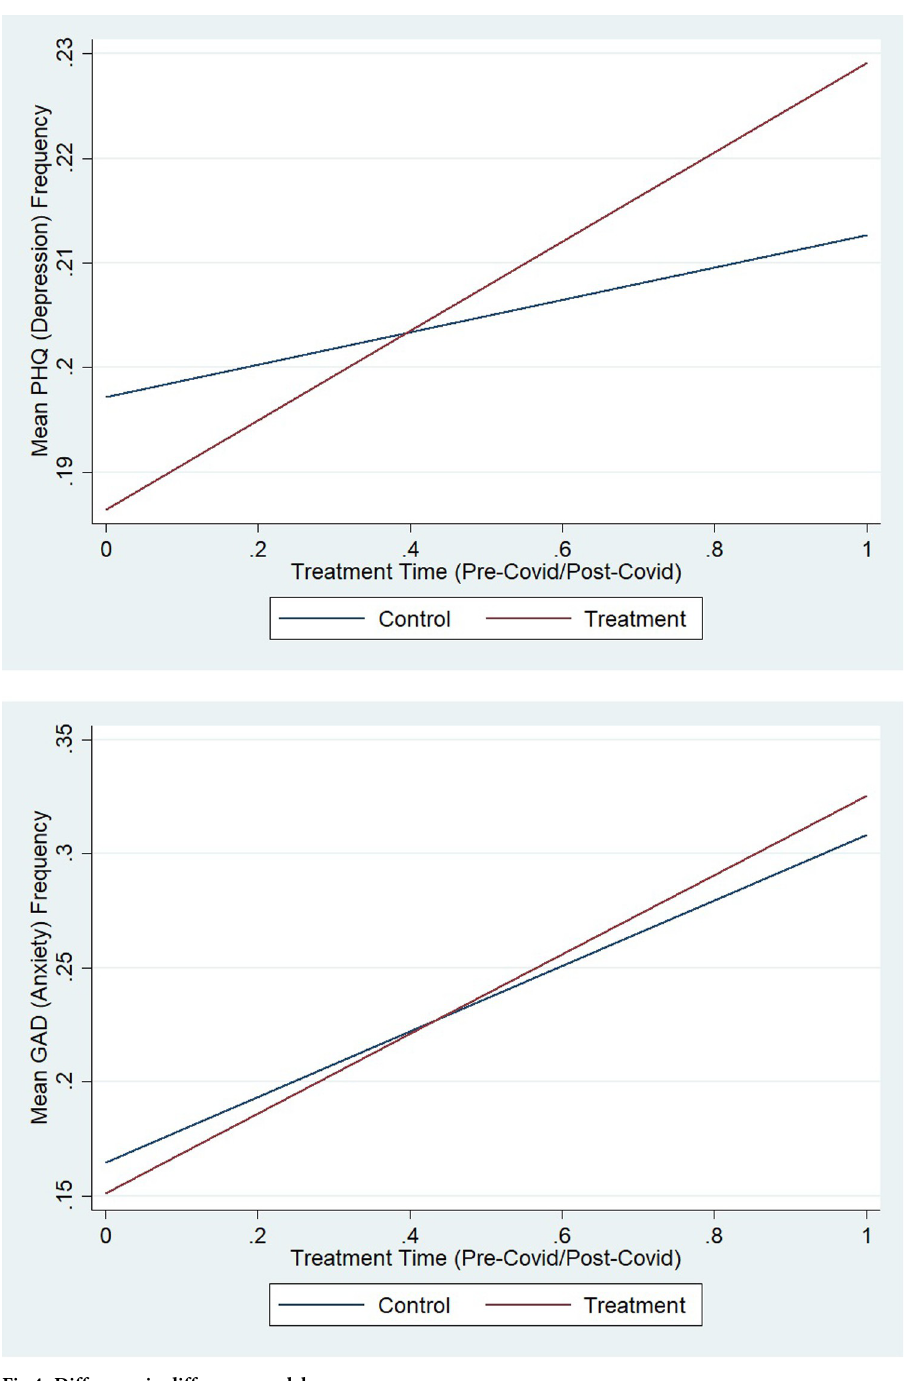
Fig 4. Difference in difference